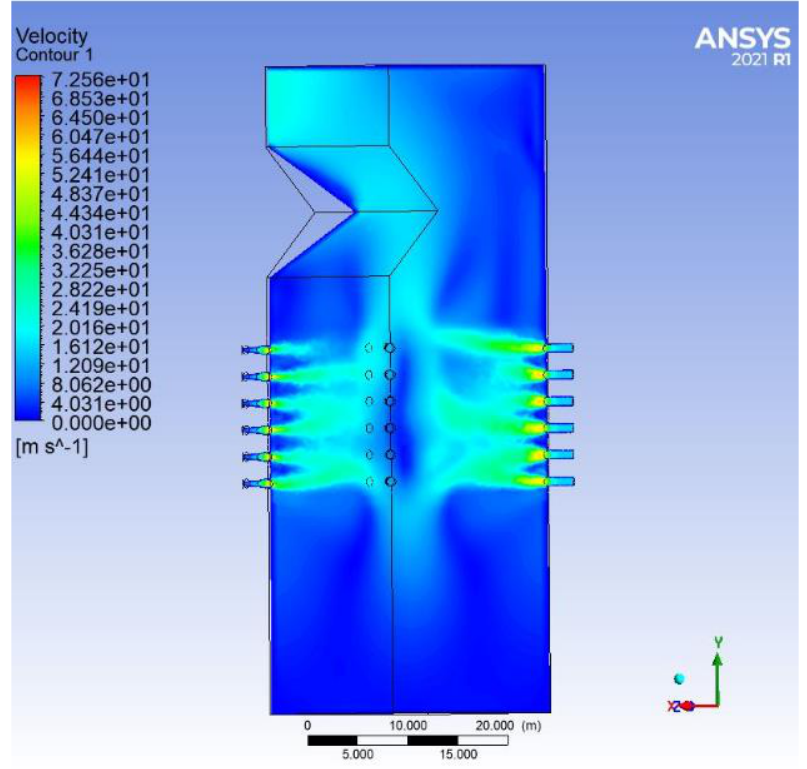
Figure 13. Velocity distribution of flue gas in case-VI.